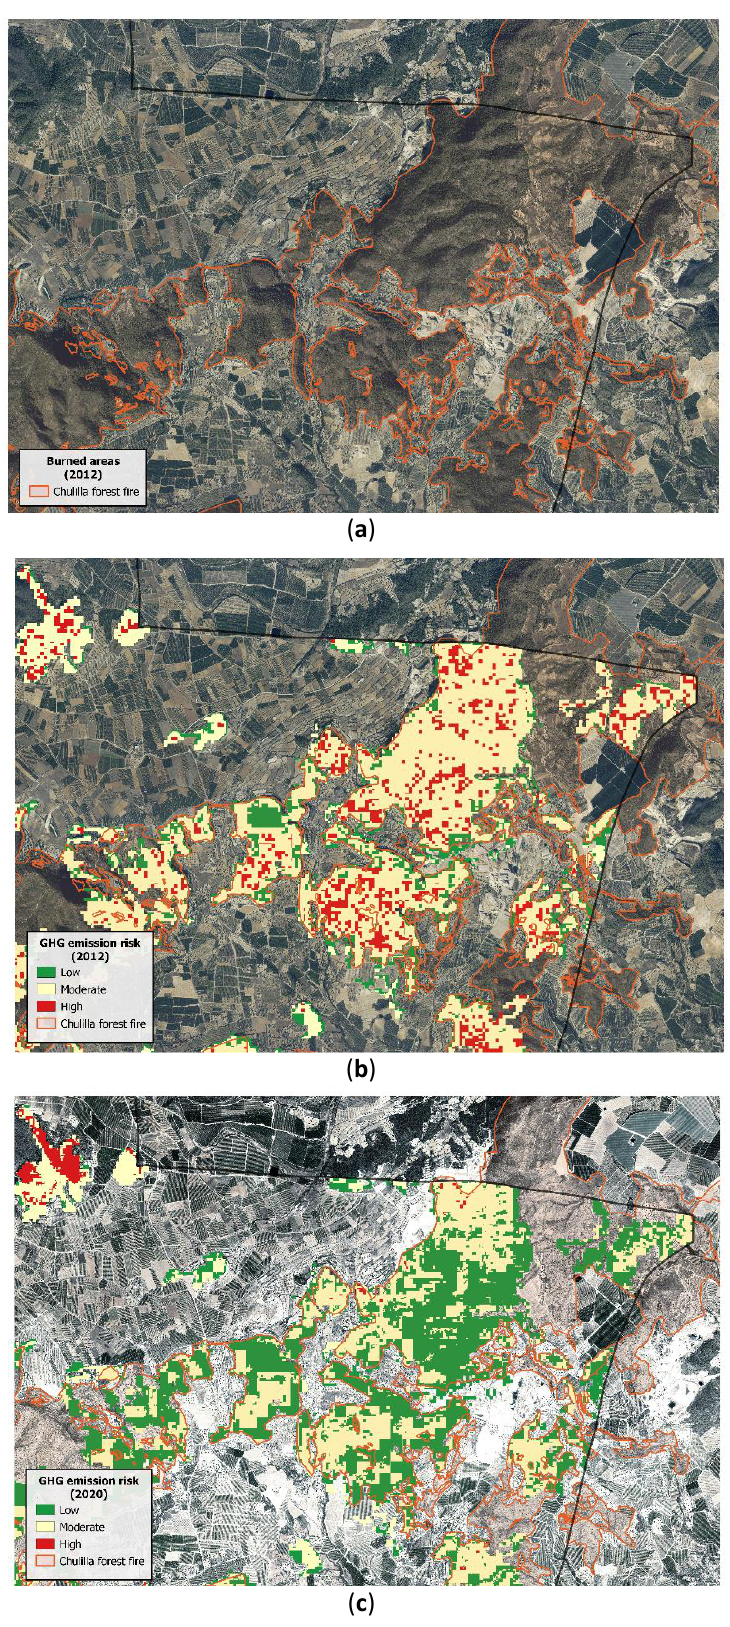
Figure 7. ( a ) Scale-up of Chulilla forest fire (2010 orthophoto). ( b ) GHG emission risk in 2012. ( c ) GHG emission risk in 2020.